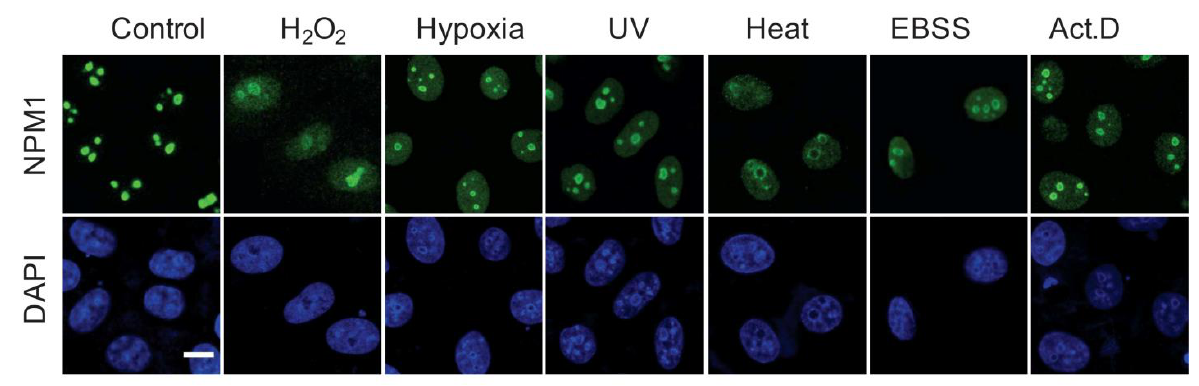
FIGURE 3: NPM1 translocation under nucleolar stress. Representative images of NPM1 translocation in HeLa cells under various nucleolar stresses, including H 2 O 2 (500  M, 30 min), hypoxia (1% O 2 , 1 h), UV irradiation (100 J m -2 ), heat-shock (42°C, 30 min), EBSS starvation (6 h) and Act.D (8 nM, 1 h), examined by immunofluorescence with anti-NPM1 antibody. Bar, 5  m. Image from ref